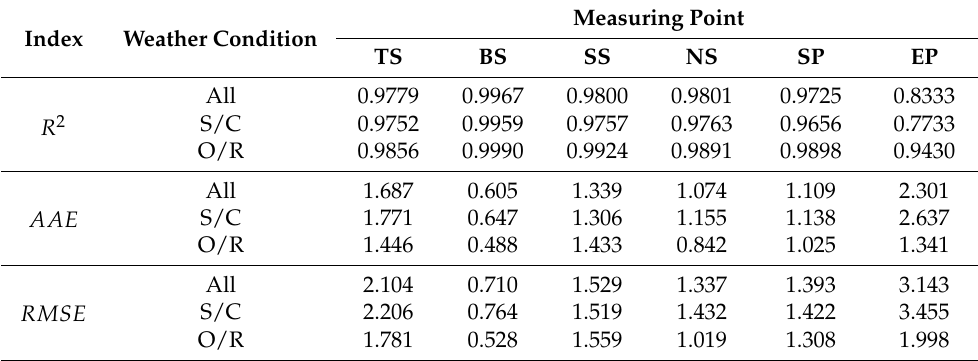
Table 3. Calculated results of evaluation